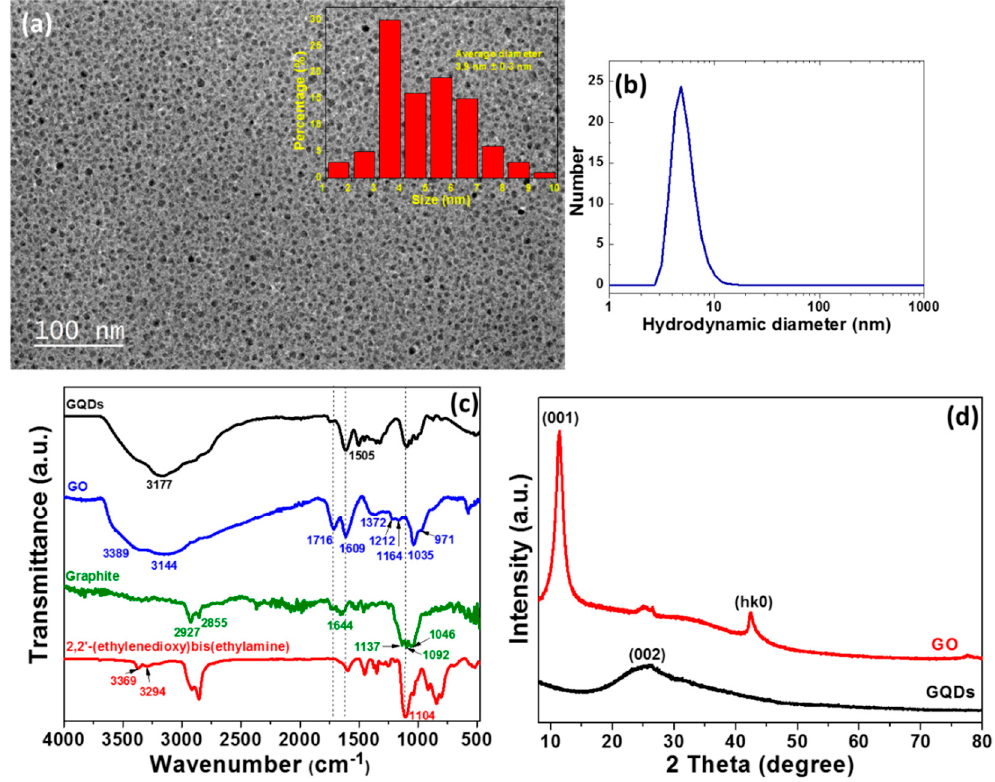
Figure 2. ( a ) Transmission electron microscopy (TEM) image and ( b ) dynamic light scattering (DLS) size data of GQDs. The inset of ( a ) is the TEM size distribution determined from the average of ca. 100 measurements. DLS measurements (mean ± s.d.) were from N = 3 independent experiments. ( c ) FT- IR spectra of 2,2’-(ethylenedioxy)bis(ethylamine), graphite, GO and of GQDs. ( d ) X-ray powder diffraction (XRD) patterns of GO and GQDs.